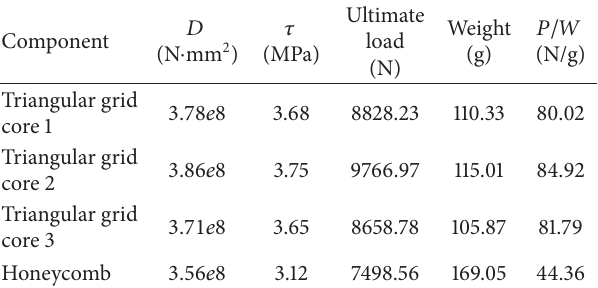
Table 3: Comparison of mechanical properties in different sand- wich structures.